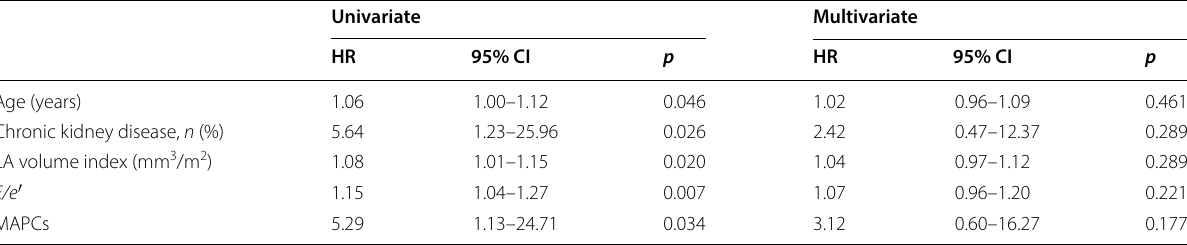
CI confidence interval, E / e ′ ratio of the peak early diastolic mitral inflow velocity to early diastolic mitral annulus peak velocity, HR hazard ratio, LA left atrium, MAPCs multiple atrial premature